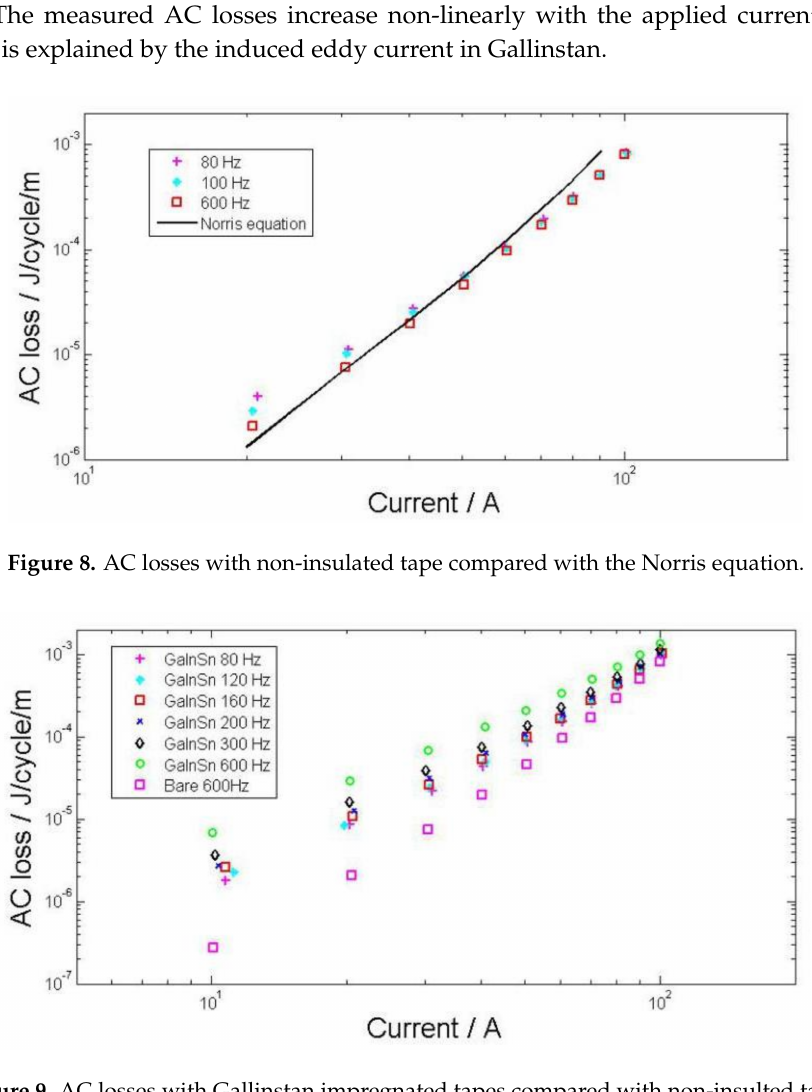
Figure 9. AC losses with Gallinstan impregnated tapes compared with non-insulted